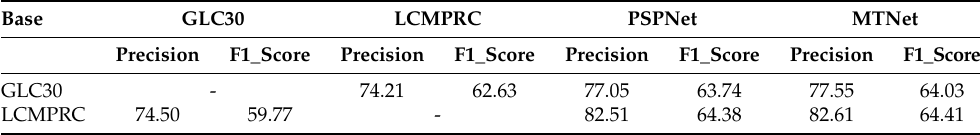
Figure 10. Detailed classification results for the original Landsat images and corresponding land cover maps, where ( a1 – d1 ) are original Landsat images, which were used for the producing of GLC30 and the results of PSPNet and MTNet; ( a2 – d2 ) are classification results from the Land Cover Map of People’s Republic of China; ( a3 – d3 ) are classification results from the GLC30; ( a4 – d4 ) are classification results of PSPNet and ( a5 – d5 ) are classification results of MTNet. Table 5. Jointly Comparison